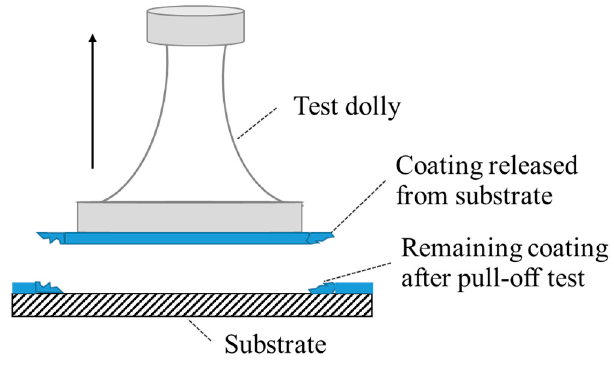
Figure 10. Schematic diagram of the pull off test.